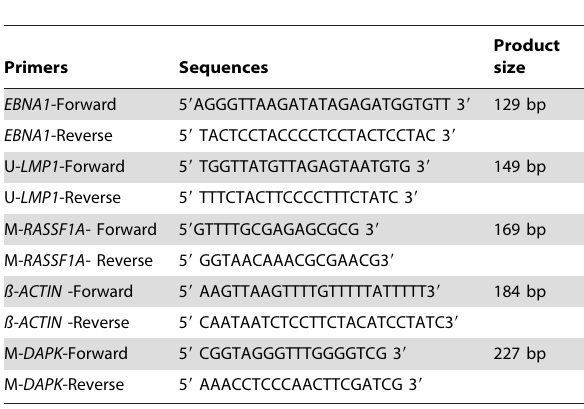
Table 1. Summary of the primers used in the present study.